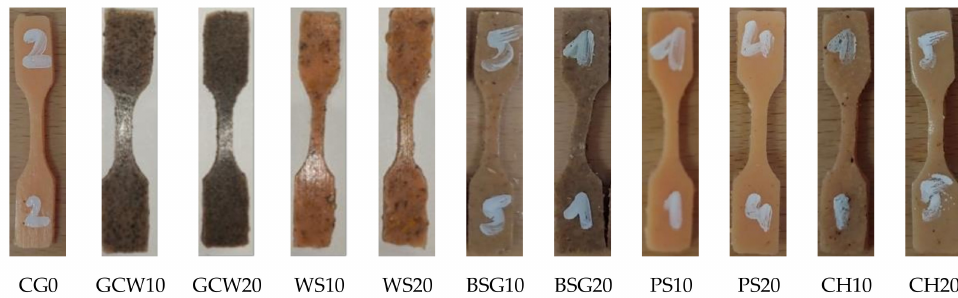
Figure 2. Prepared composites.